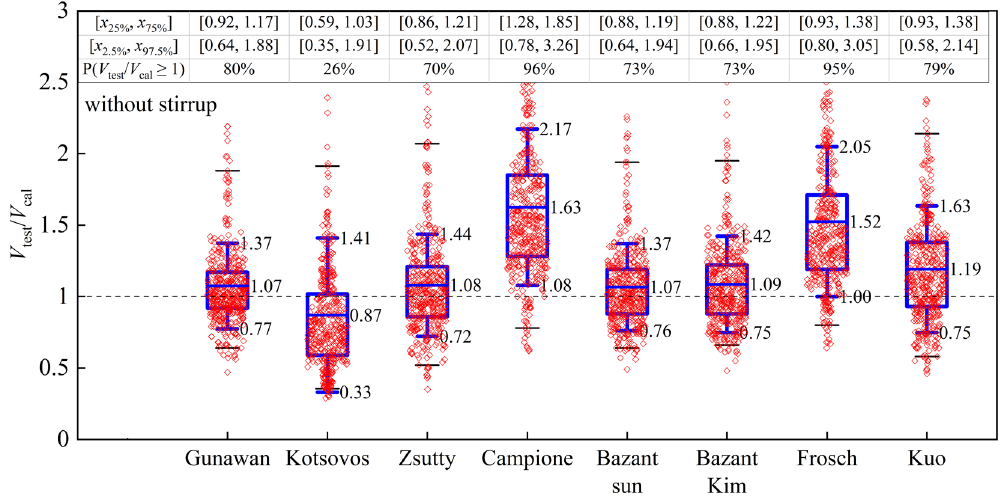
Figure 3. Researchers: overall prediction results for beams without stirrup.